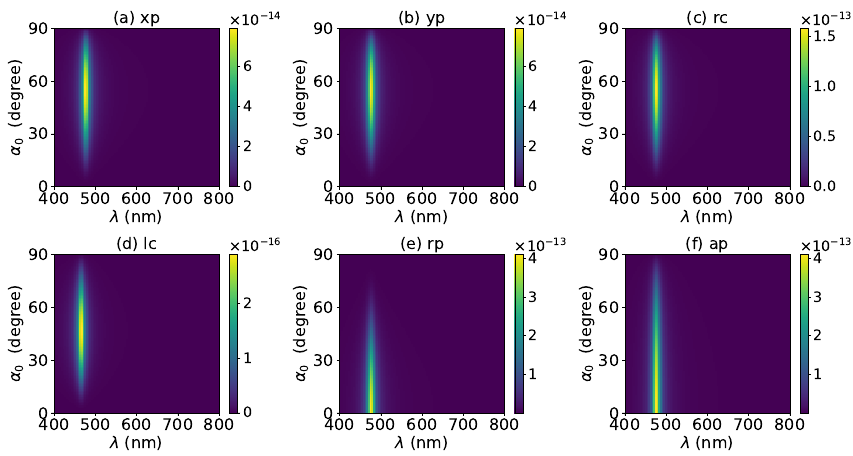
Figure 7. The axial optical force F z of a first-order Bessel beam centered on a graphene-coated gold nanosphere. The layer number is N = 0, which means the particle is a gold nanosphere without graphene coating. Panels ( a – f ) correspond to linear, circular, radial, and azimuthal polarizations,